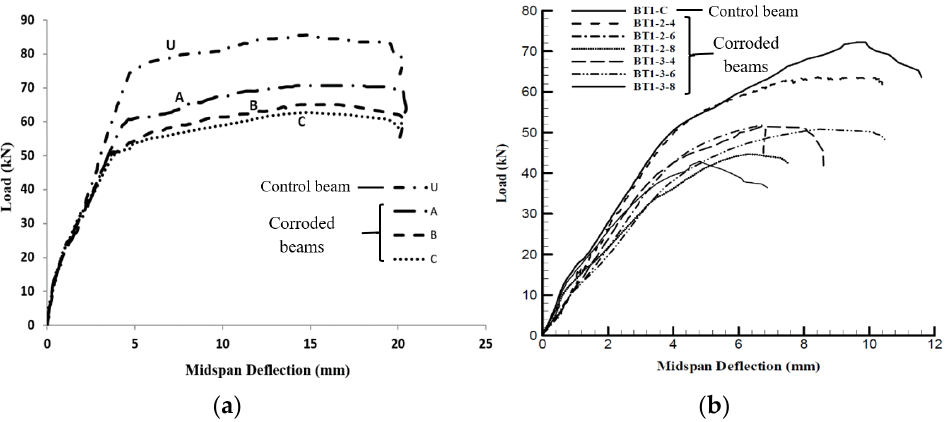
Figure 14. Load vs. midspan deflection curves of ( a ) the present study and ( b ) Azher [68]. Table 1. Summary of the flexural testing